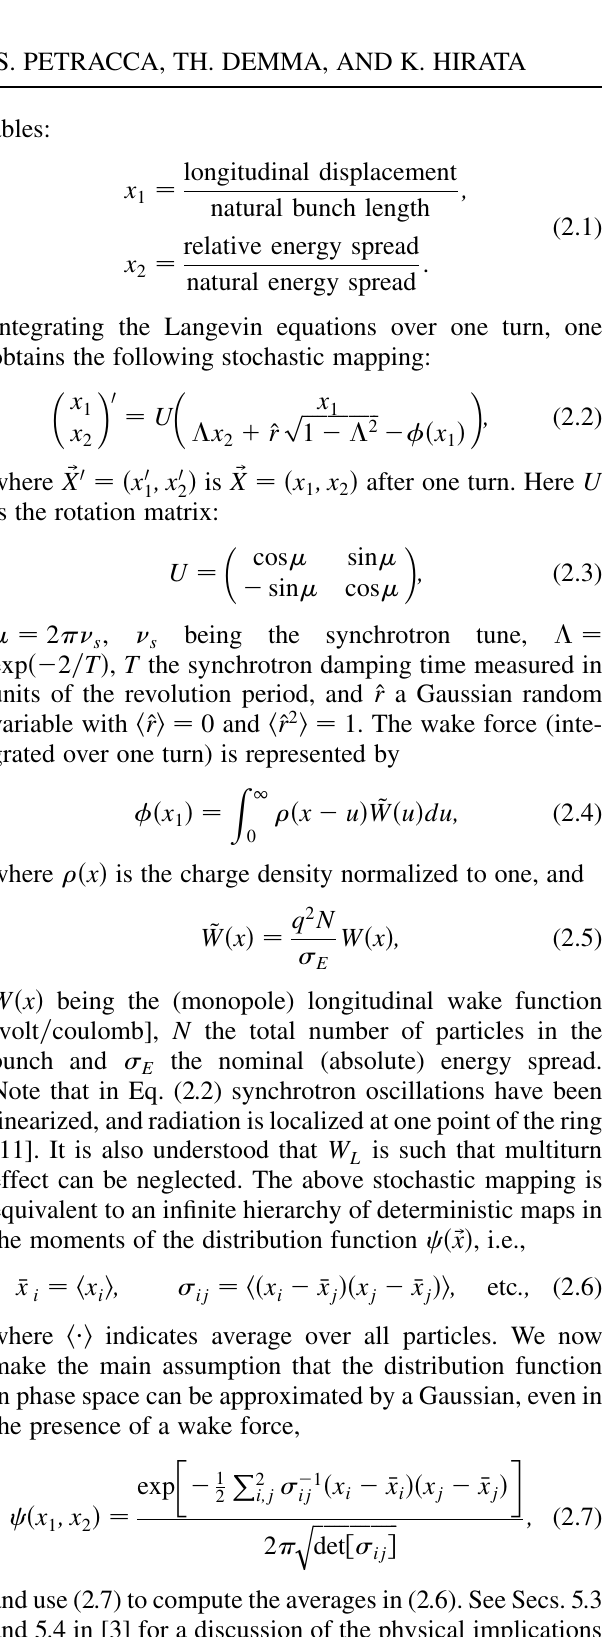
(cid:6) 0 : 085 . Light s